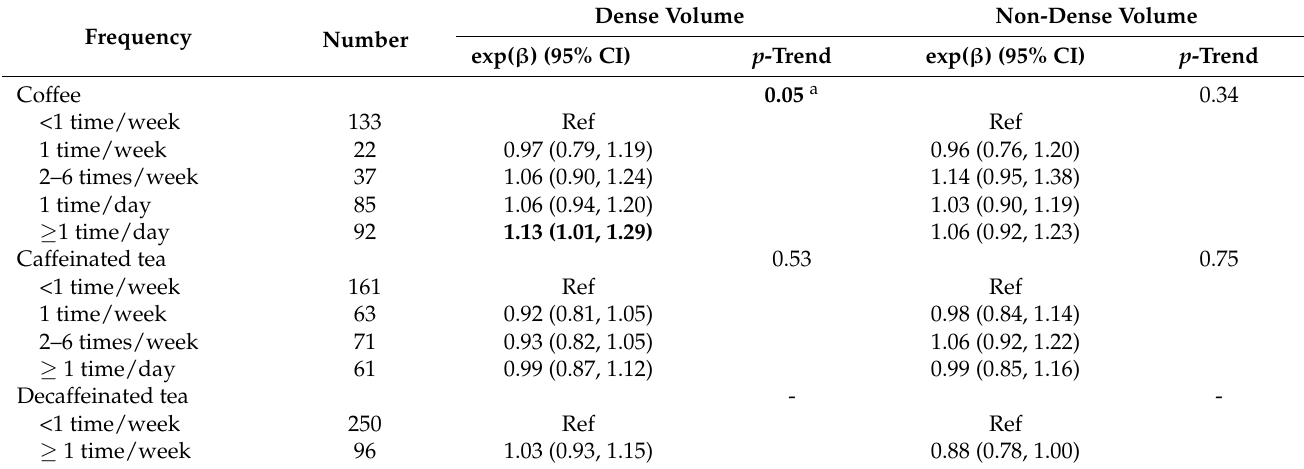
Table 3. Associations of coffee/tea intake with dense volume and non-dense volume in premenopausal women